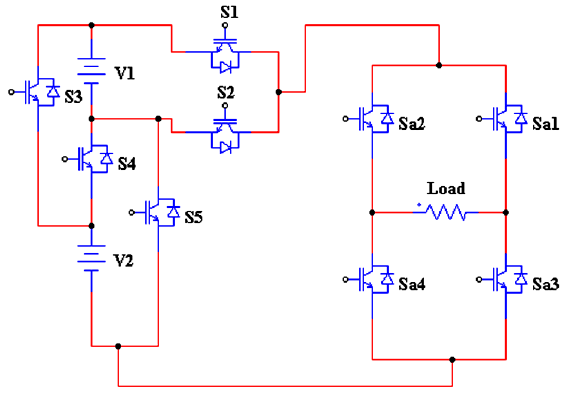
Figure 22. Reduced switch MLI circuit.